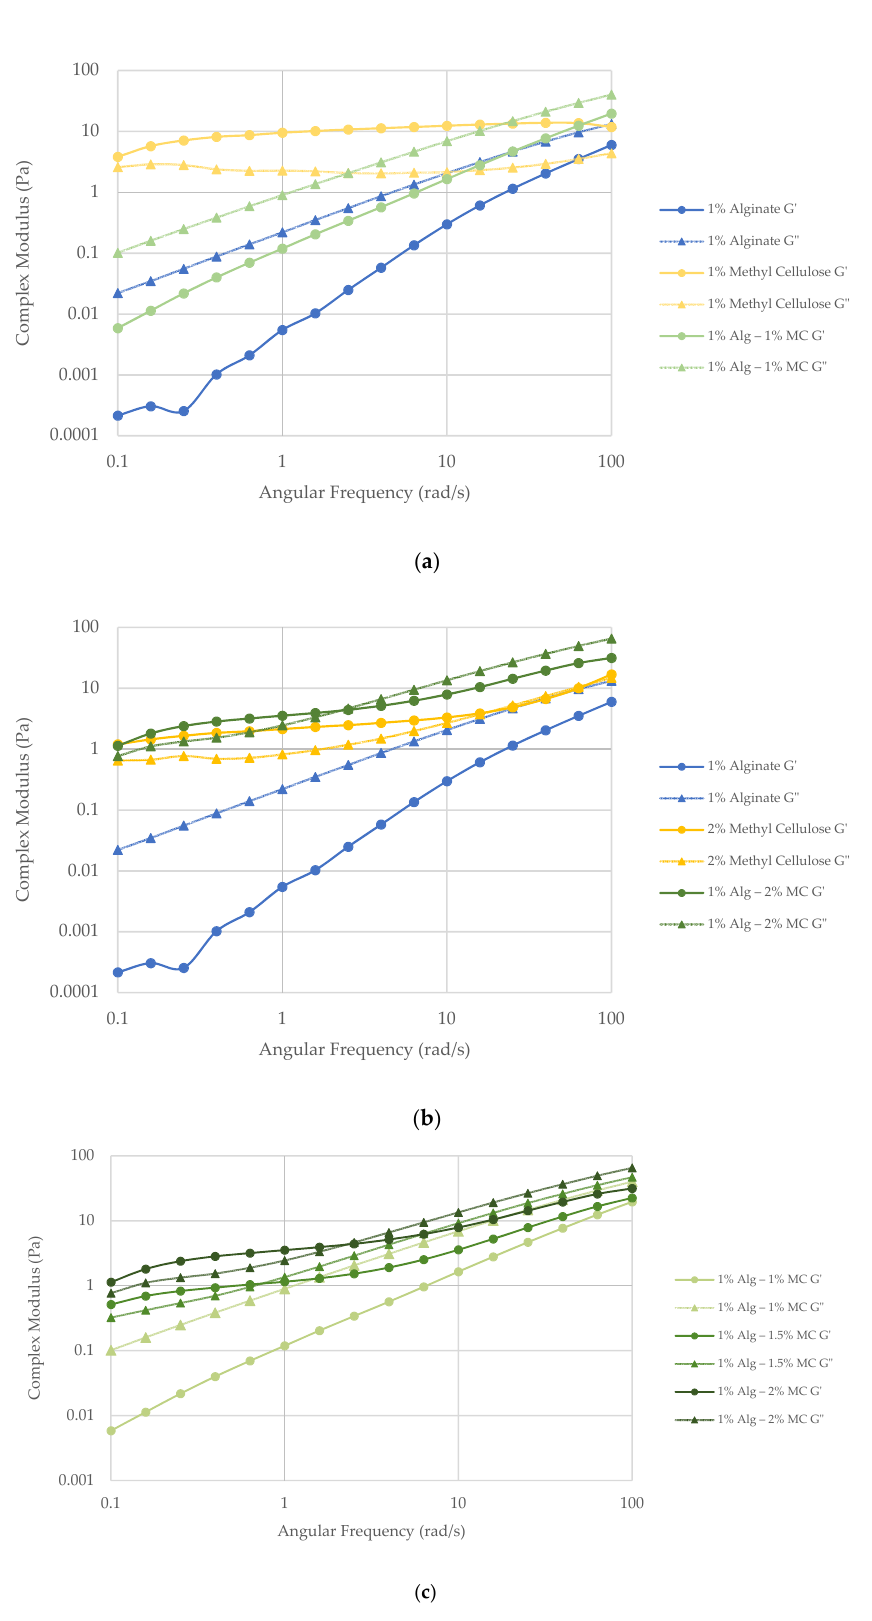
Figure 5. Viscoelastic moduli G’ ( • ) and G” ( (cid:78) ) of the resulting gel systems: ( a ) 1% w/v alginate (blue), 1 % w/v methylcellulose (yellow), and the mixture of the two (green); ( b ) 1% w/v alginate (blue), 2% w/v methylcellulose (yellow), and the mixture of the two (green); ( c ) Alginate-methylcellulose mixtures with varying methylcellulose concentration ( w/v ). The circular and triangular symbols appearing in the plots represent the mean-values of discrete measurements evenly acquired at logarithmic intervals under steady-state conditions, while the continuous lines are guides for the eye. G: storage modulus; G”: loss modulus. Recalling that EGF caused a slight decrease in shear viscosity behavior, the impact on dynamic modulus should give more insight into the molecular interactions happening in the system. The influence of EGF addition on each gel system with varying methyl- cellulose concentration is explored in Figure 6. The strength of the gel does not appear to be jeopardized, suggesting a more complex interrelationship. It was observed that the change in phase angle decreases with increasing methylcellulose concentration, but the viscoelastic transition is not as dependent on methylcellulose concentration when EGF is in the system. In every instance measured, EGF increased gel stiffness signifying that the loss in viscosity is not necessarily due to a loss of structure. This is conversely related to the impact of silicone in a silicated hydroxypropylmethylcellulose-alginate gel network that hindered effective alginate chain interactions and ultimately reduced gel stiffness [18]. Although elastic modulus increases with the addition of EGF, the relaxation times shift to higher frequencies meaning shorter relaxation times. This may signal a new net- work structure forming between EGF and methylcellulose due to hydrophobic interac- tion. The complexity of the ternary interdependence needs to be more substantially de- fined in order to fully interpret viscoelastic properties.